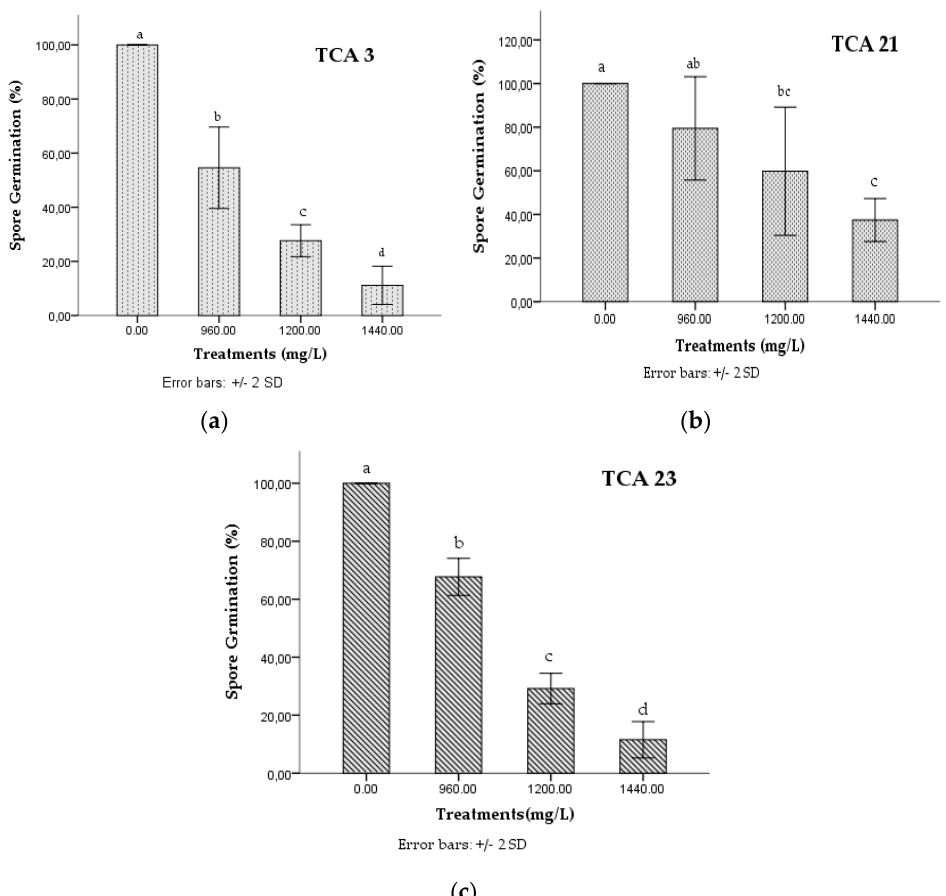
Figure 1. Effect of three concentrations of chlorpyrifos on spore germination of T. asperellum TCA 3 ( a ), T. asperellum TCA 21 ( b ), and T. harzianum TCA 23 ( c ). According to Tukey’s test, different letters mean significant differences ( p < 0.05). Error bars represent the standard deviation (SD) of the mean values ± SD of 2 readings per 3 replicates.